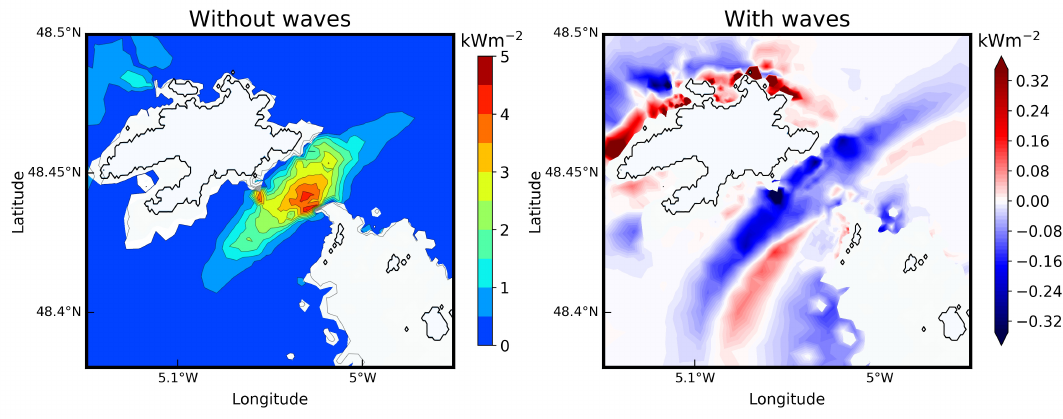
Figure 7. ( left ) Averaged predicted tidal stream power 10 m above the bed during a neap-spring tidal cycle in March 1993 (from 16 March, 16:55 UTC to 31 March, 15:35 UTC) without waves. The reference of 10 m corresponds to the operating height of horizontal axis turbines such as Sabella D10 in the strait. ( right ) Relative differences with respect to this reference simulation for the configuration with waves effects. Predictions are shown for mean water depths over 20 m. Positive values indicate an increase of mean tidal stream power, while negative values indicate reduced kinetic energy with the inclusion of waves effects (adapted from